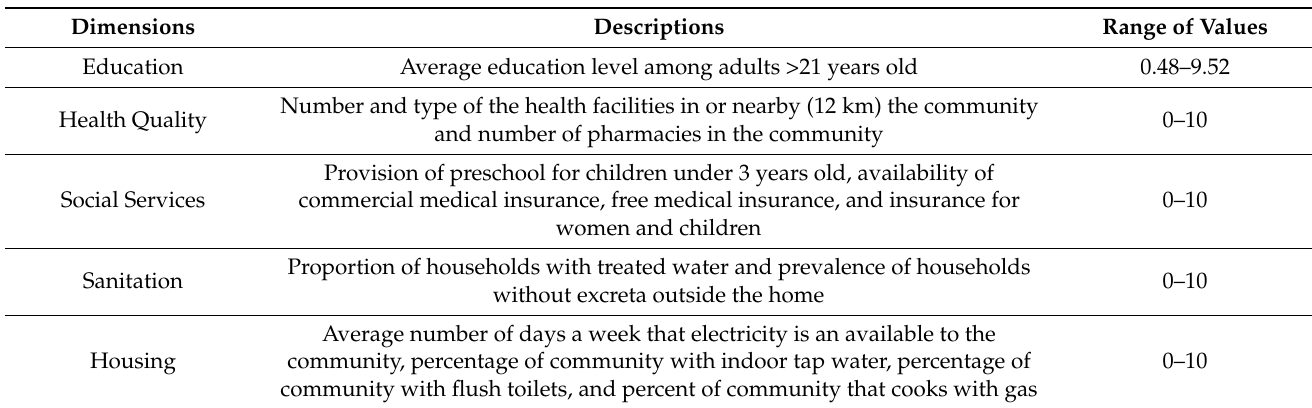
Table 1. Dimensions, indicators and descriptions of community deprivation